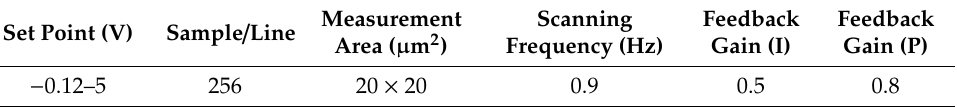
Figure 2. The Agilent 5400 AFM. Table 2. AFM scanning parameters.